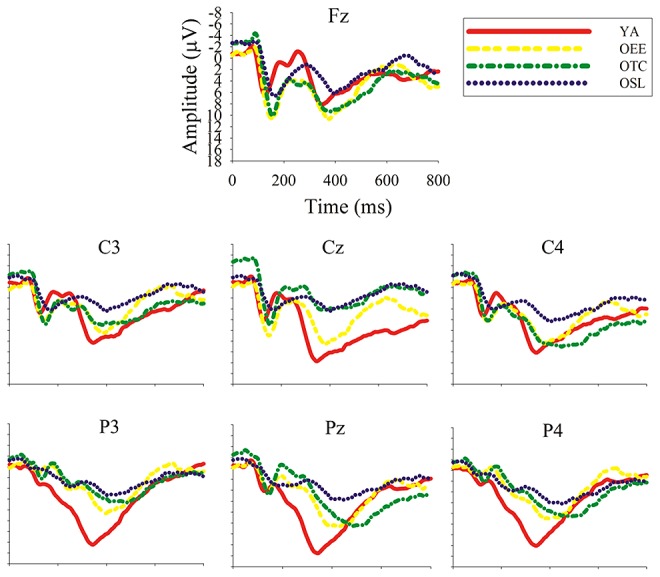
Grand average ERP waveforms for the averaged homogeneous and heterogeneous conditions for the four groups at seven electrode sites.